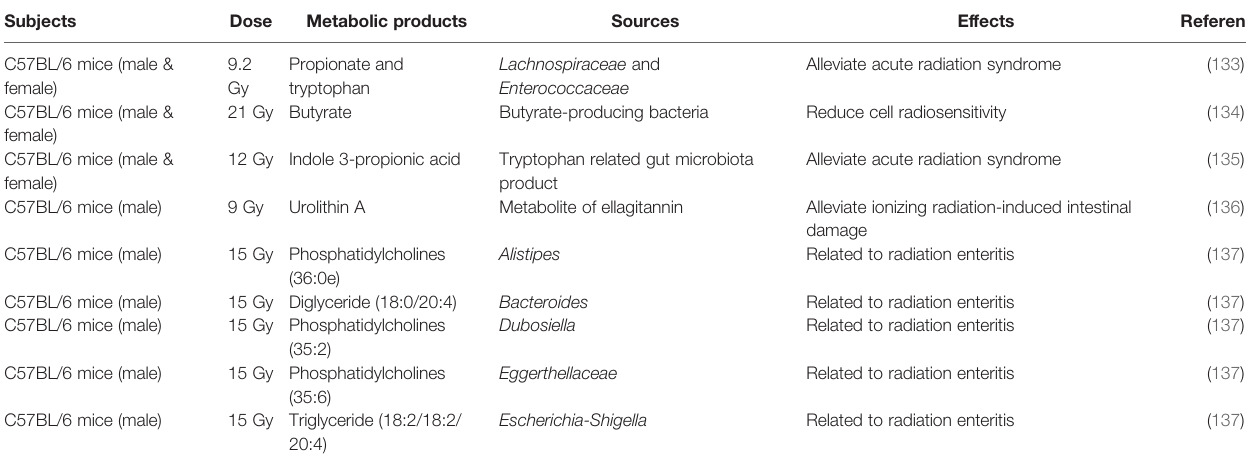
TABLE 1 | Metabolic products and possible sources related to radiation-induced